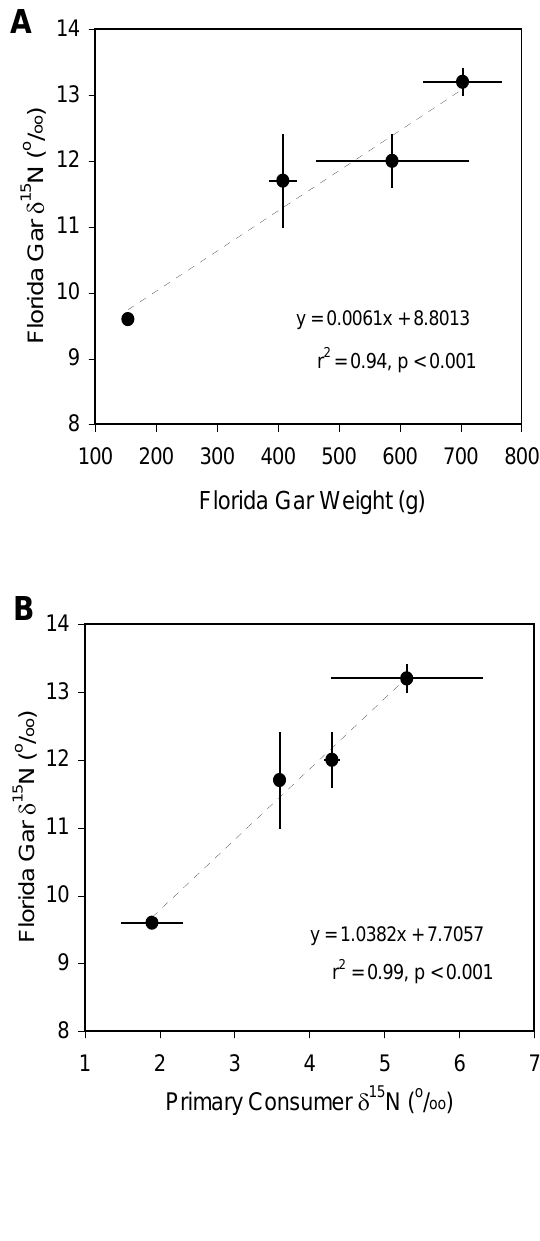
FIGURE 3. Average δ 15 N values (+ one standard error) for Florida gar, plotted as a function of fish wet weight ( A ) and δ 15 N of primary consumers ( B ). Dashed lines are least squares regression